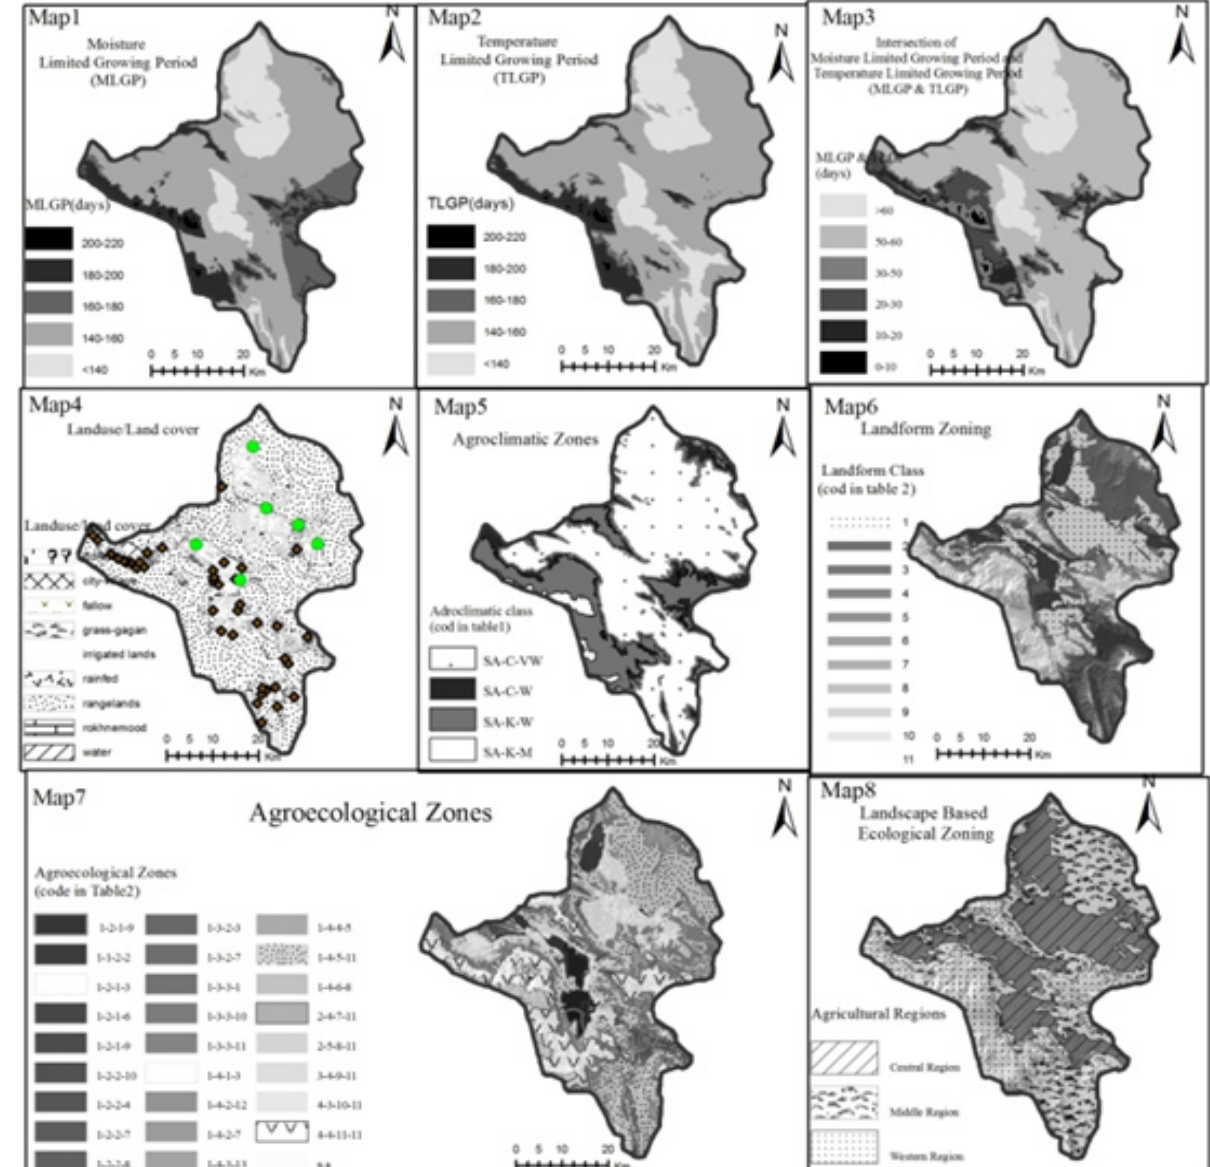
Fig. 3. Important spatial information outputs, achieved from Agroecological zoning